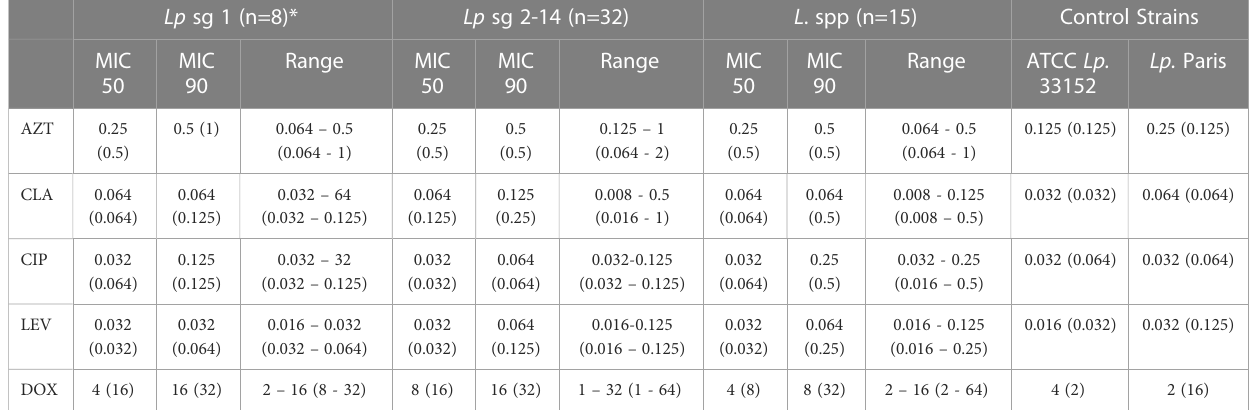
TABLE 2 MIC 50 , MIC 90 , and range values of fi ve antibiotics for segregated serological groups of 57 environmental isolates obtained by manual and automated reading (within